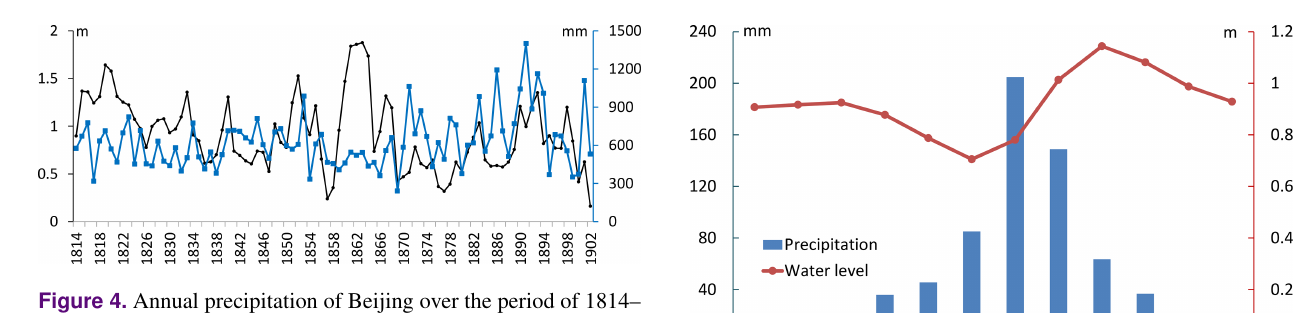
Figure 4. Annual precipitation of Beijing over the period of 1814– 1902 (thick blue line with squares) and its comparison with the an- nual mean water level of Lake Machang (thin black line with dots).